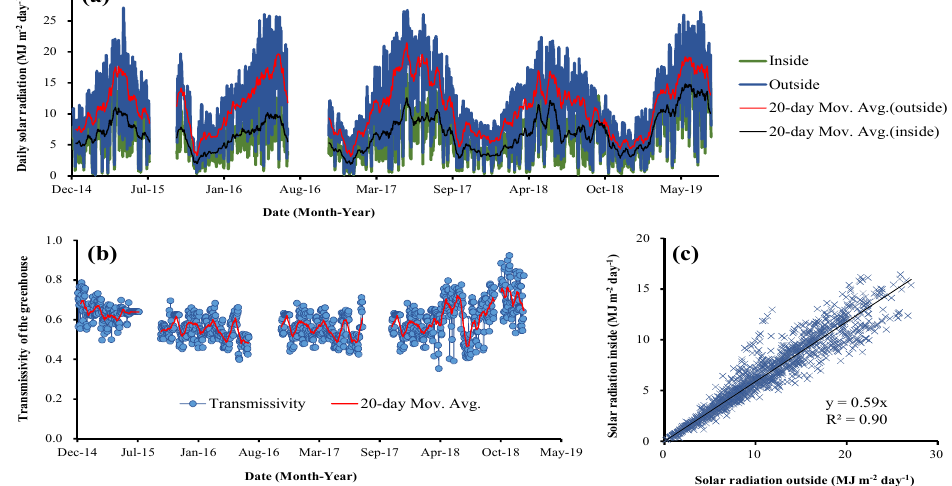
Figure 2. Daily solar radiation inside and outside ( a ), the daily transmissivity of the sunken solar greenhouse ( b ), and the relationship between inside and outside solar radiation ( c ) during the seven seasons. Thin solid black and red lines on ( a ) represent the 20-day moving average of radiation inside and outside, respectively, and the thin red solid line on ( b ) represents the 20-day moving average of the greenhouse transmissivity.